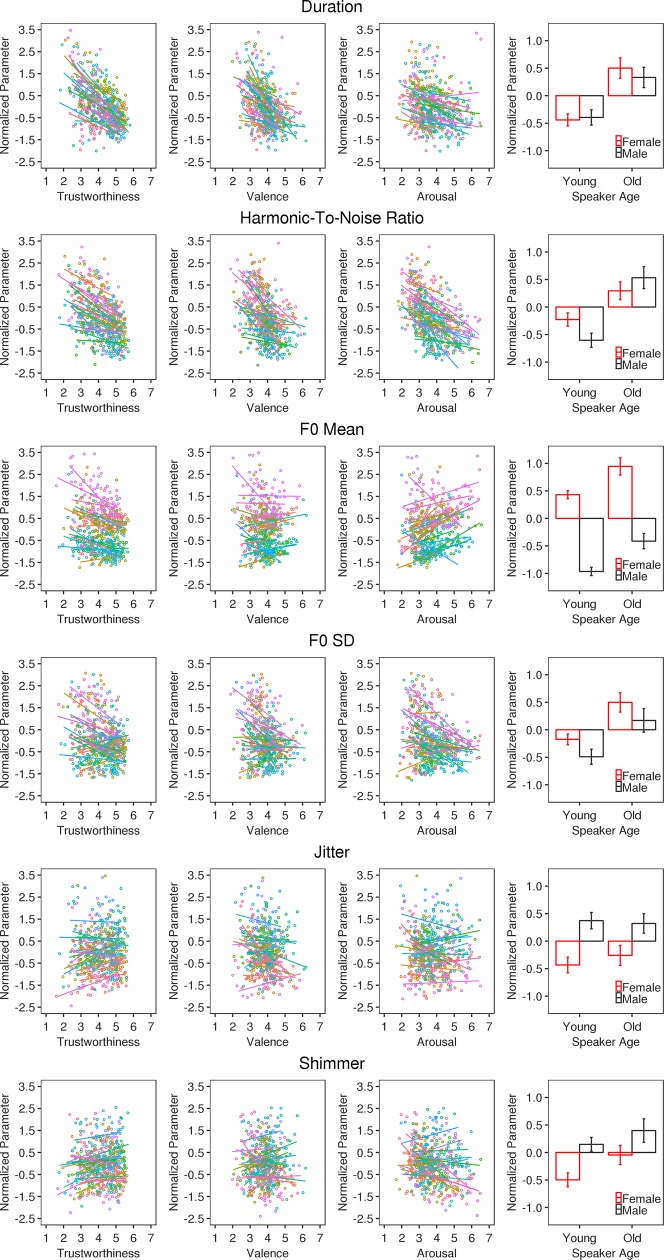
Illustration of the relationship between acoustic measures and other stimulus properties.Normalized vocal parameters (y-axes) are plotted as a function of trustworthiness ratings, valence, arousal, and speaker characteristics (x-axes). The individual points in the scatter plots represent the 13 expressions for the 2 sentences produced by each speaker. These points are summarized by a regression line for each speaker. The error bars in the bar-graphs represent the 95% confidence intervals.